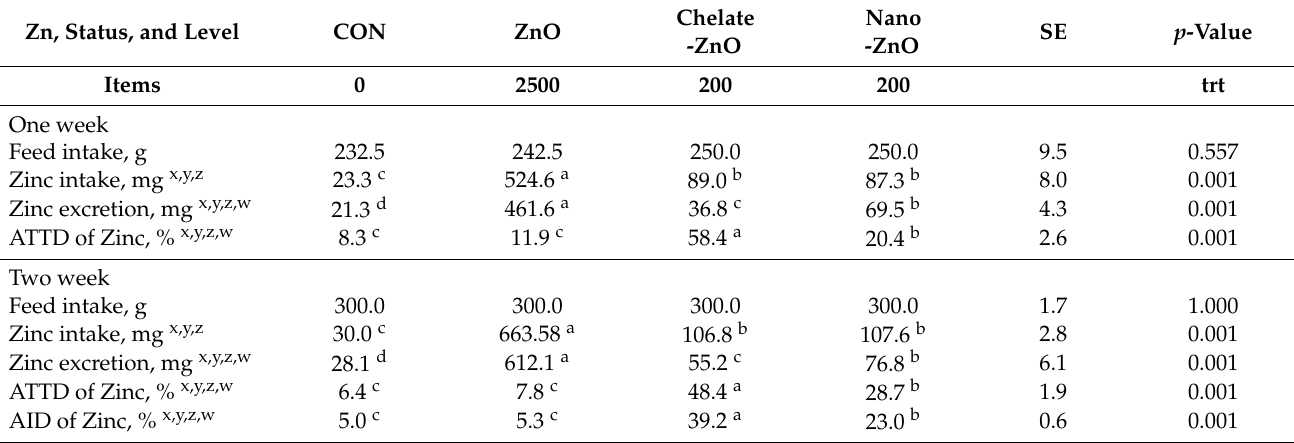
Table 5. Effects of different forms of zinc oxide on apparent total tract and ileum digestibility in weaned piglets ( n = 20).